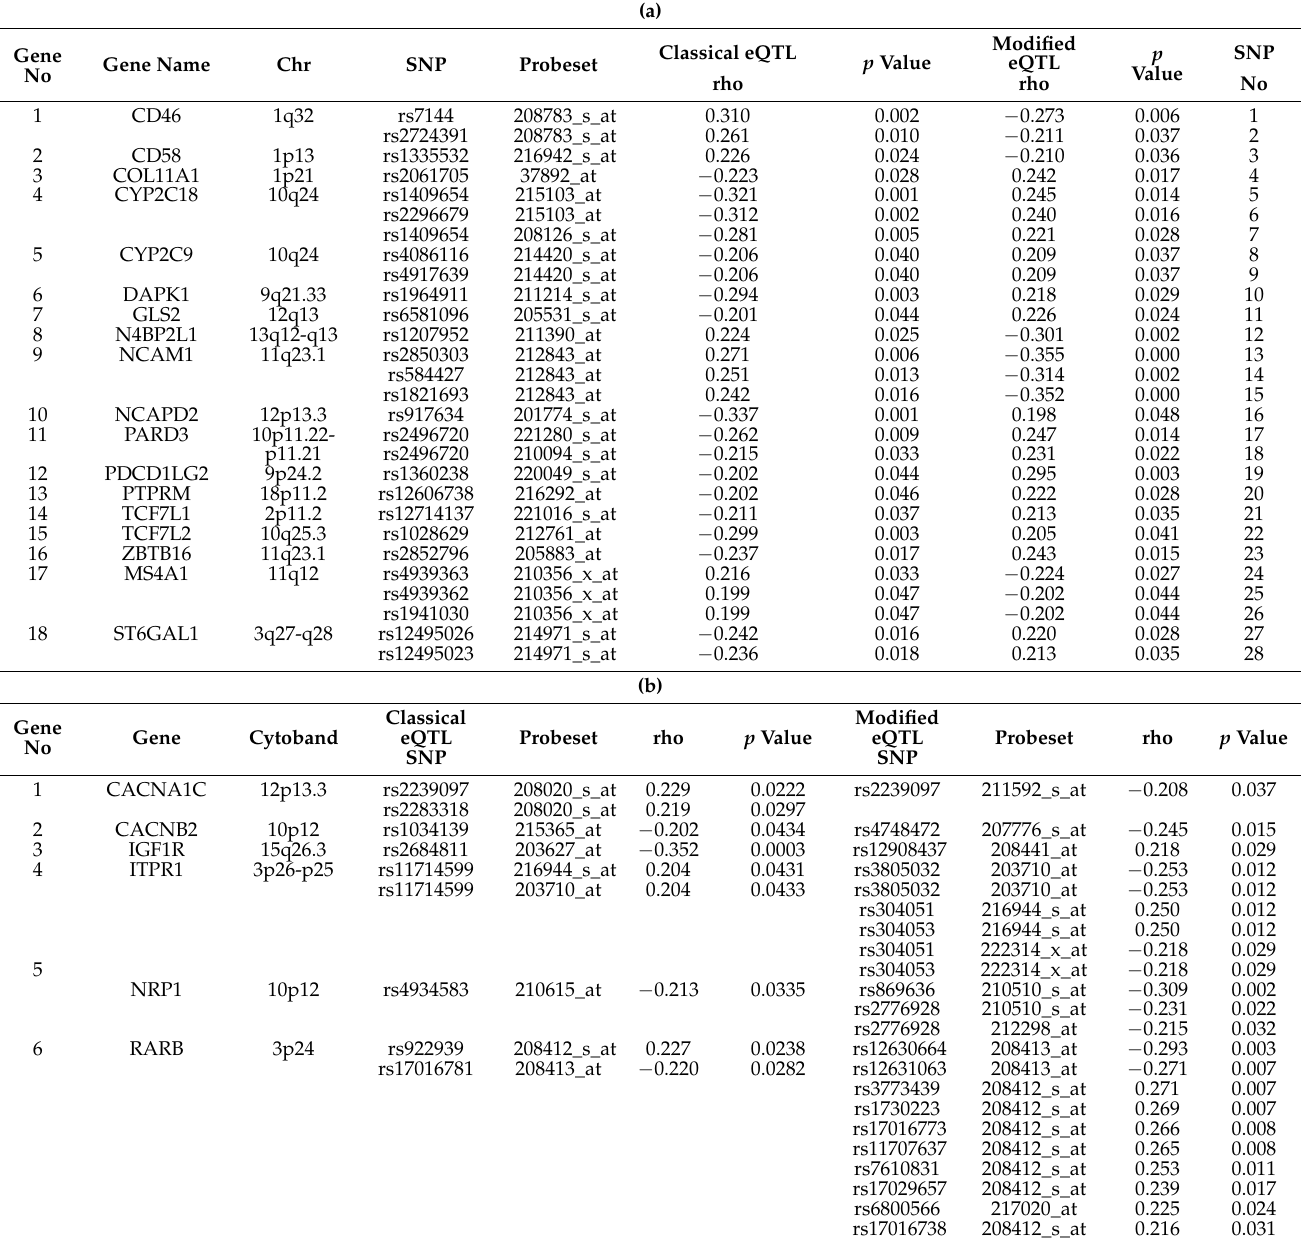
Table 1. The two sets of eQTL results from the classical and modified analyses had 24 genes in common. ( a ) Shared 18 of the 24 genes were in 28 probe–SNP pairs with the same probes and SNPs shared by the two sets of results. ( b ) Shared 6 of the 24 genes did not have the same probes and SNPs between the two sets.